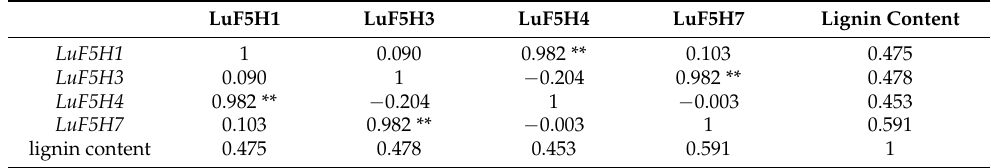
** represents p < 0.01, * represents p < 0.05.